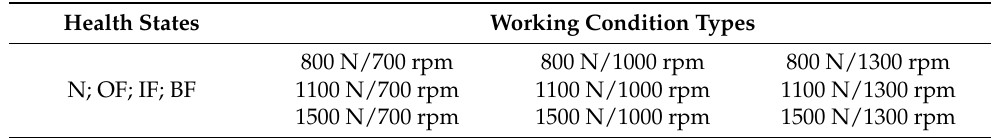
Table 1. Working conditions of NU205